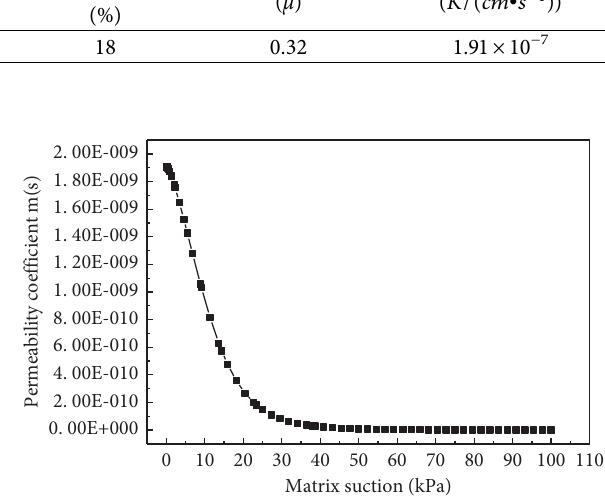
Figure 4: Variation curve of the permeability coefcient with matric